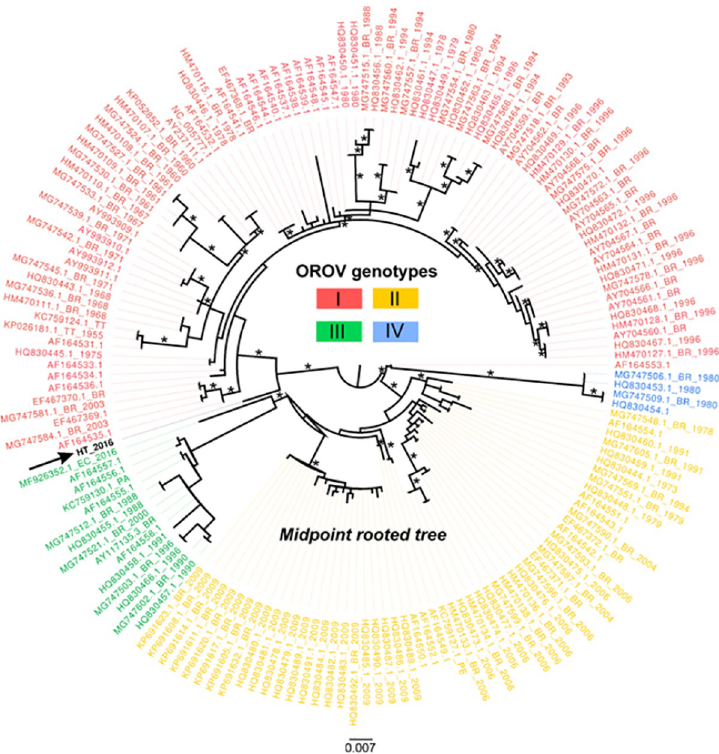
Fig 7. Maximum likelihood (ML—IQ-Tree) midpoint rooted tree based on 166 representative Small segment sequences (693 sites) of different OROV strains. Tips are colored according to genotype. The OROV sequence of this study (GenBank no. MN264269) is identified by the arrow and bolded name. Tip labels refer to GenBank accession code, country of origin (BR, Brazil; PE, Peru; EC, Ecuador; PA, Panama; HT, Haiti; TT, Trinidad and Tobago), and year of isolation. Asterisks indicate SH-aLTR/aBayes/ultrafast bootstrap support values. Only values equal or greater than 75% are shown. Branch lengths are drawn in scale of nucleotide substitutions per site according to the bar in the figure.